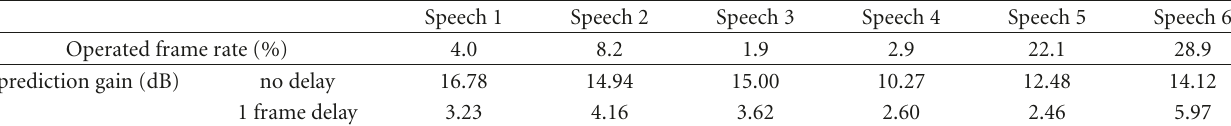
Figure 1: Block diagram of the encoding process of AAC-LTP [13]. Table 1: The prediction gain of AAC-LTP.